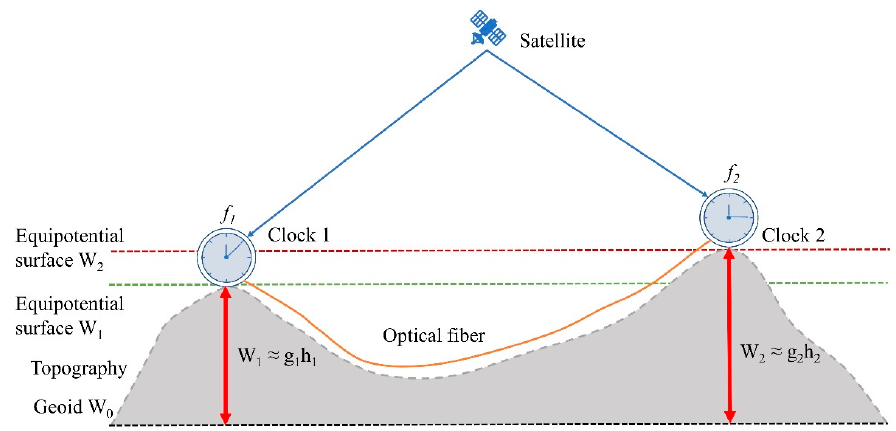
Figure 1. Schematic of chronometric leveling.